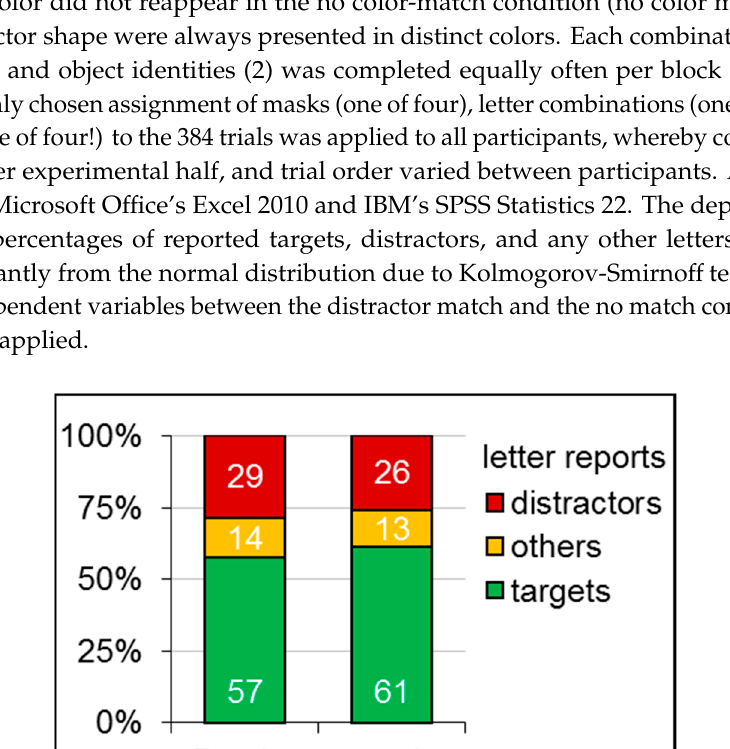
Figure 4. The plot shows mean percent of reported target ( green ), distractor ( red ), and other letters ( orange ) for the two color match conditions of Experiment 2: distractor ( D ) and no match with the cue’s irrelevant color.